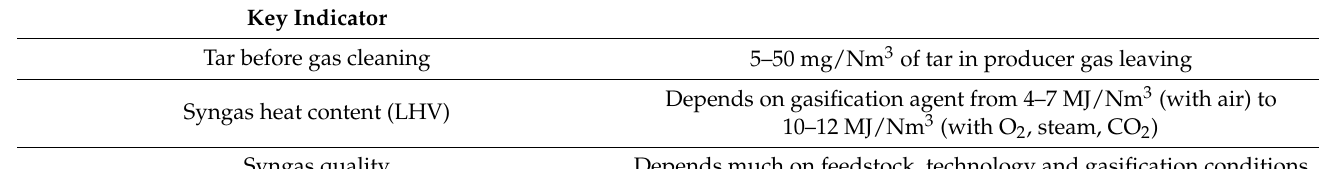
Table 4. Key indicators for selecting gasification technology